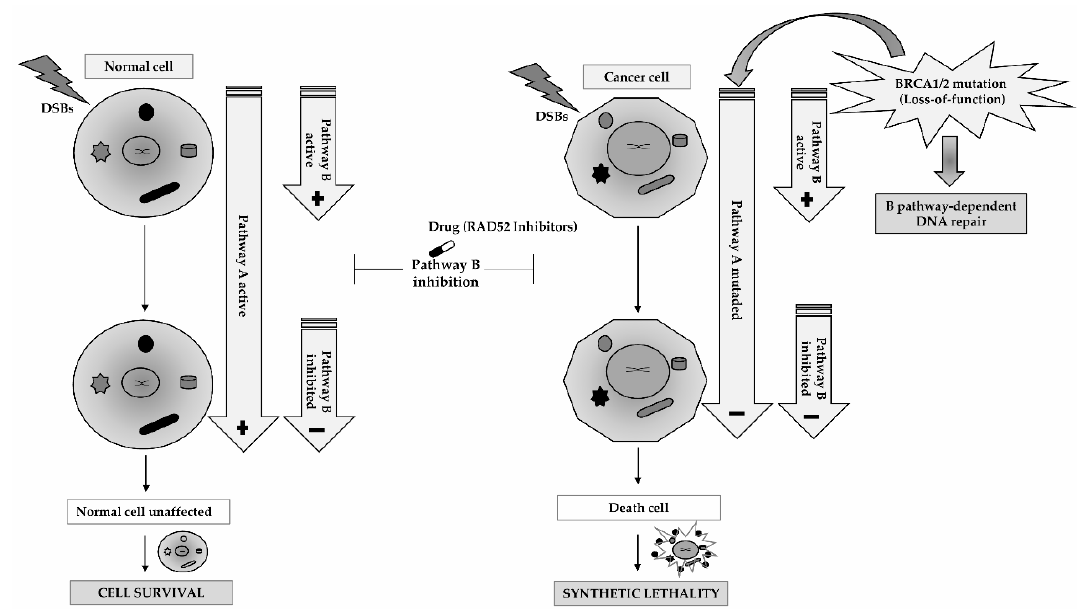
Figure 3. Synthetic lethality by targeting the RAD52 gene. The resolution of the DSBs depends on two pathways (Pathways A and B) associated with homologous recombination repair. In BRCA- deficient cancer cells, the HR pathway activity is reduced due to the presence of mutations in BRCAs genes (Pathways A) leading to loss-of-function. An alternative pathway dependent on RAD52 (Pathway B) needs to be activated, when the major repair pathway dependent on BRCA genes are inactive. However, if the RAD52 -dependent pathway is simultaneously inhibited using inhibitors drugs of RAD52 activity can induce cancer cells death. Therefore, the inhibition of RAD52 is synthetically lethal with BRCA -deficiency. On the other hand, in normal cells the inhibition of RAD52 activity (Pathway B) is compensated by normal function of BRCAs genes (Pathways A) and the cells are unaffected promoting cellular survival.